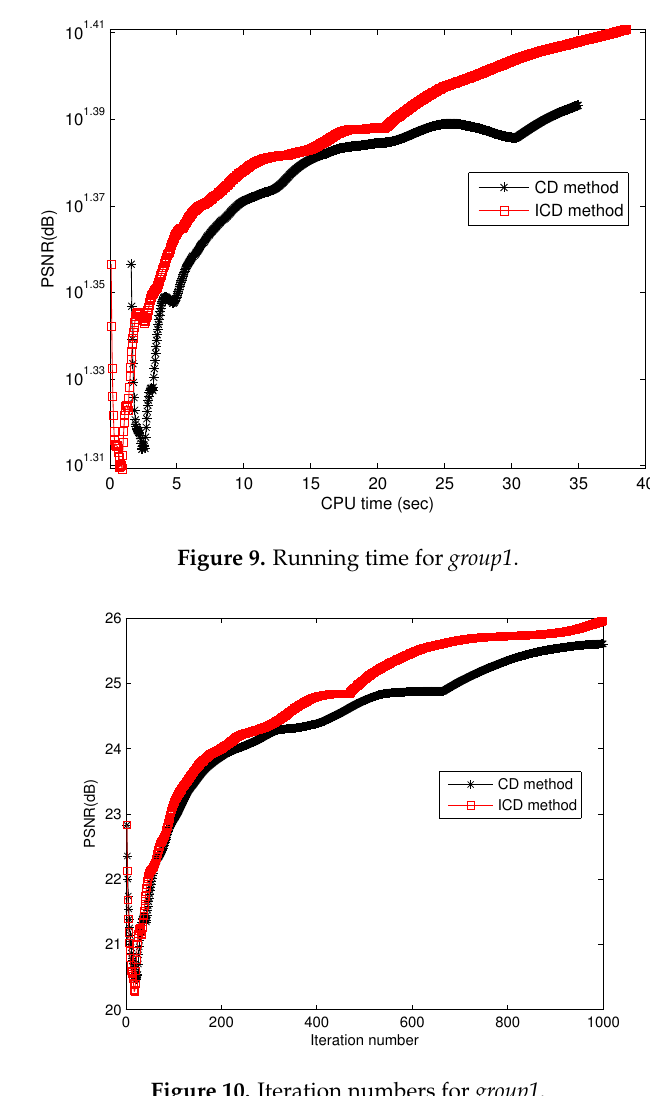
Figure 10. Iteration numbers for group1